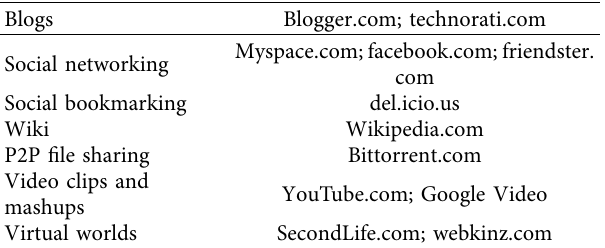
Figure 3: Growth of major websites ([17]: Global Digital Yearbook). Table 1: Some new social